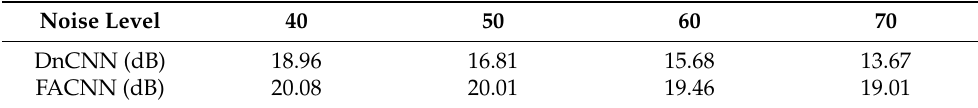
Table 3. The variations of SNR with respect to the noise